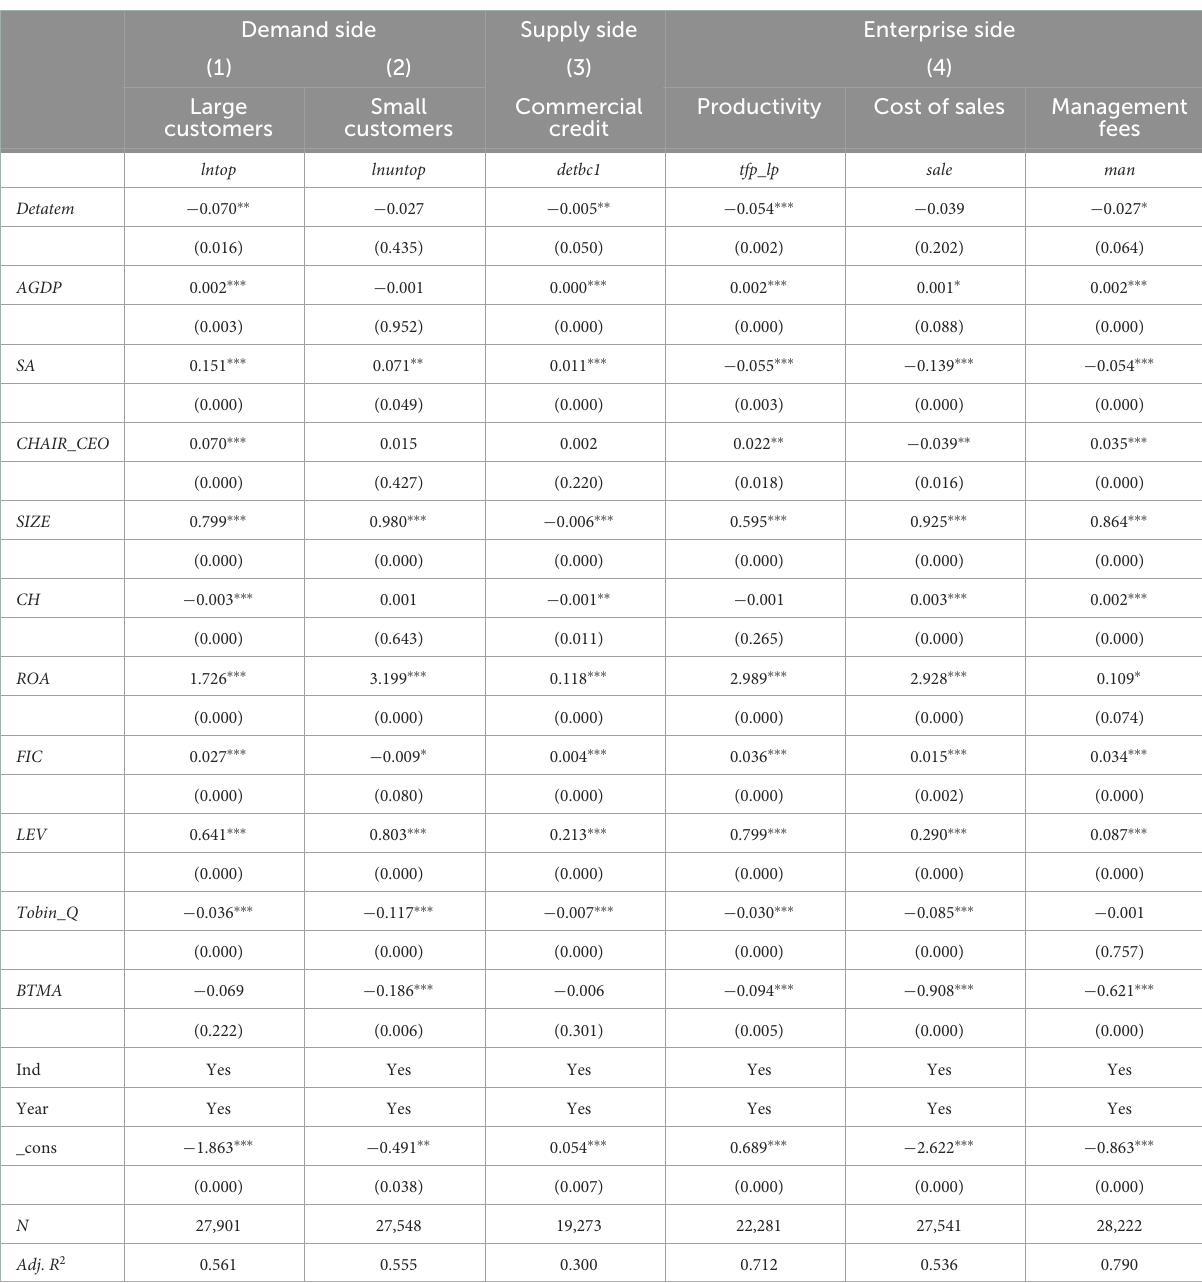
TABLE 8 Regression results for the mechanism of action. Demand